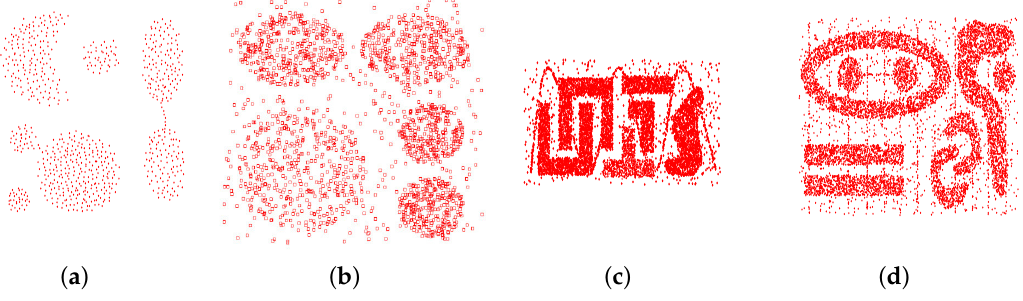
Figure 4. Four data sets used in experiments. ( a ) Aggregation. ( b ) DS1. ( c ) t4.8k. ( d ) t7.10k.